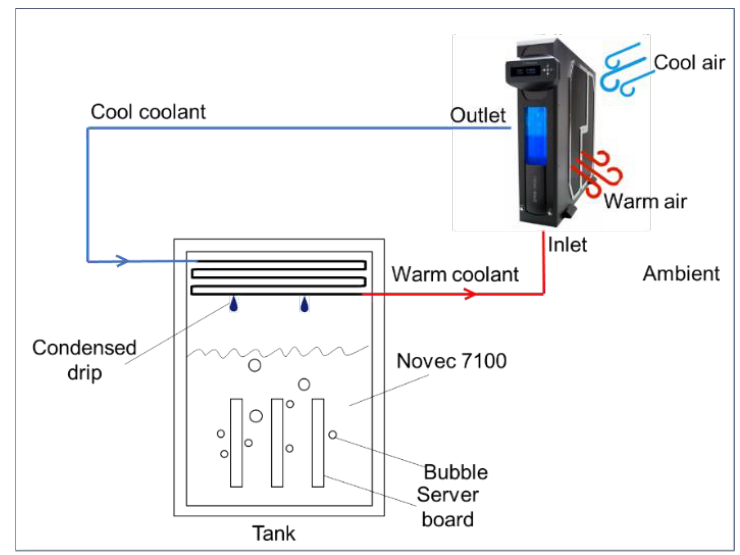
Figure 1. Scheme of the two-phase CPU immersion cooling system.